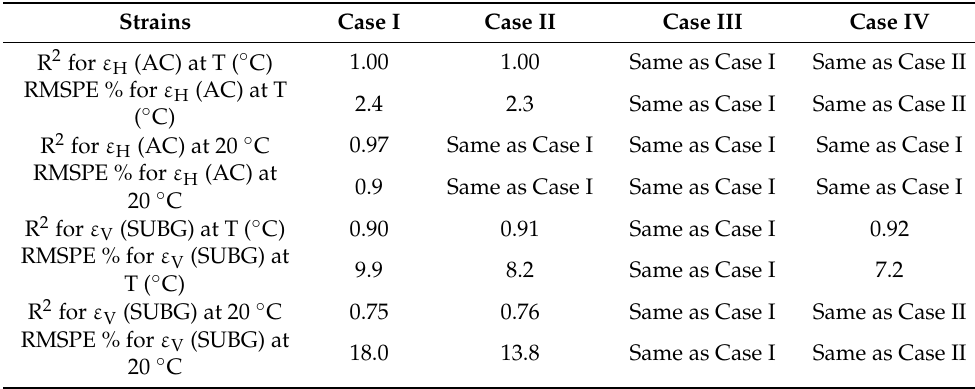
Table 7. Regression analysis results. Strains